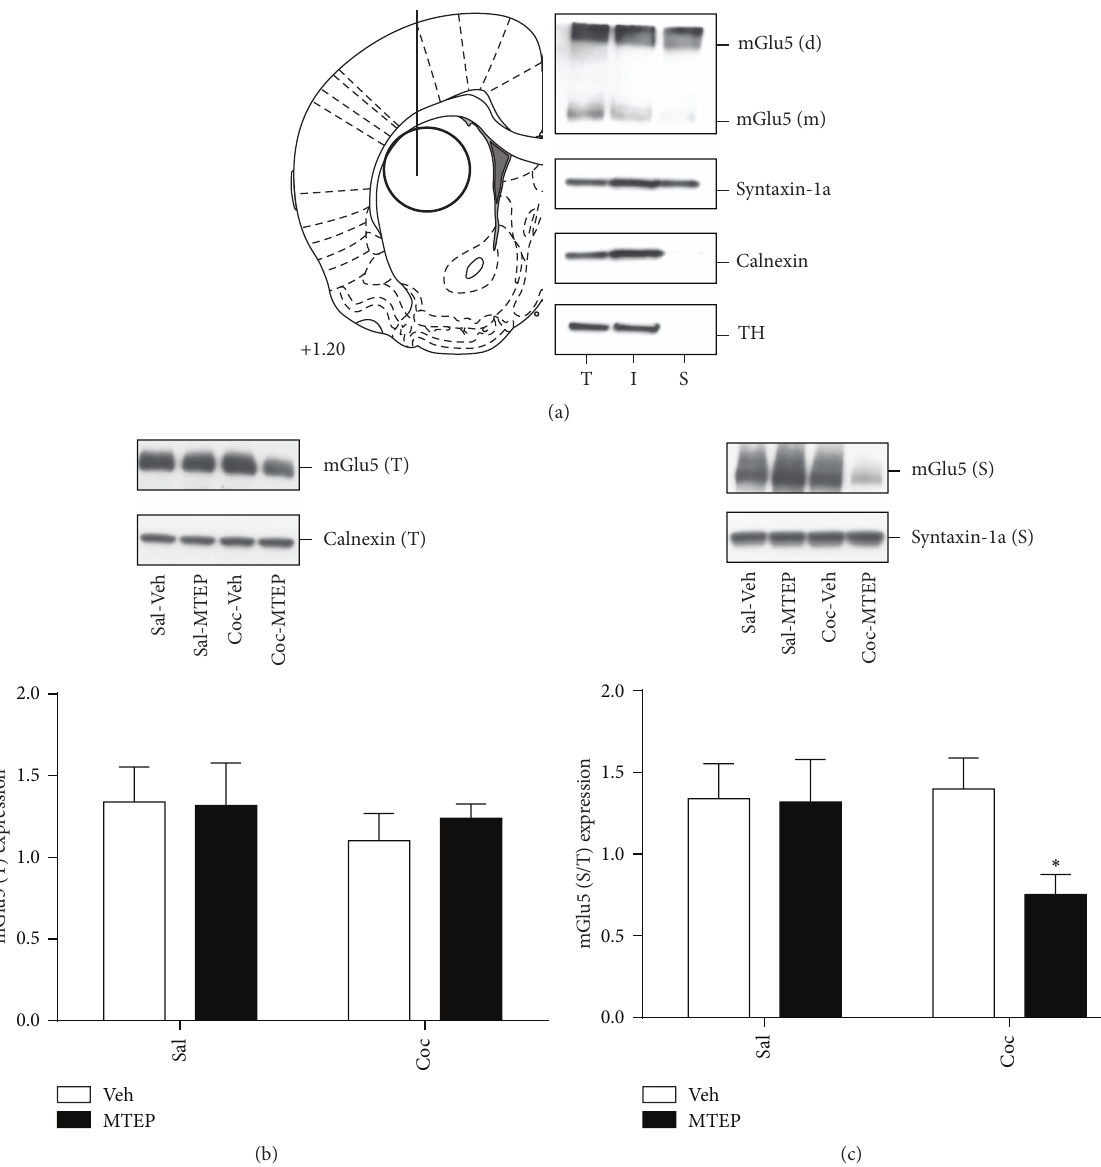
Figure3:SurfaceexpressionofmGlu5receptorsinthedlSTRisreducedexclusivelyinanimalswithhistoryofcocaineself-administrationand context-primed relapse that also received intra-dlSTR infusion of MTEP. (a) Left panel: an outline of the coronal rat brain section according to Paxinos and Watson [13] demonstrating the site of drug microinjection relative to dSTR tissue dissection. Right panel: representative immunoblot analysis of fractions (T: total lysate, I: intracellular fraction, and S: surface fraction) prepared by surface biotinylation of the dlSTR slices. In addition to mGlu5, distribution of plasma membrane protein (syntaxin-1a), endoplasmic reticular protein (calnexin),